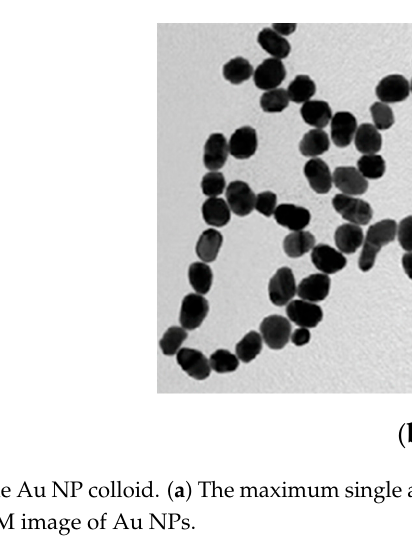
Figure 1. Schematic illustration of the preparation of the Au-TPP substrate and the SERS detection process.